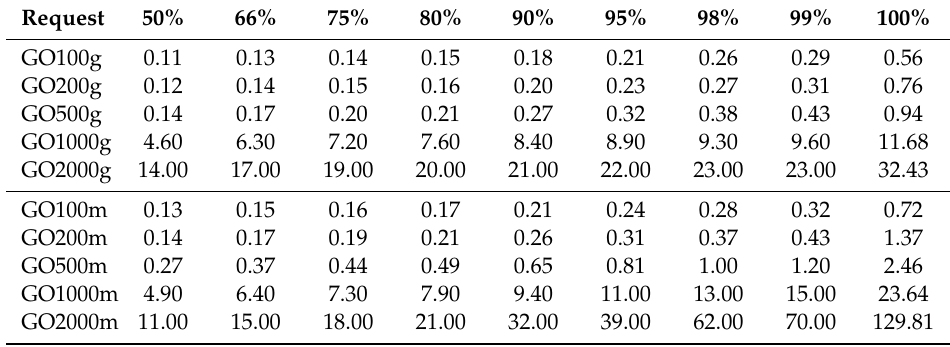
Table 7. Percentage of getObservation requests completed within given times (in seconds) for the di ff erent configuration of concurrent users and WSGI server (case A).